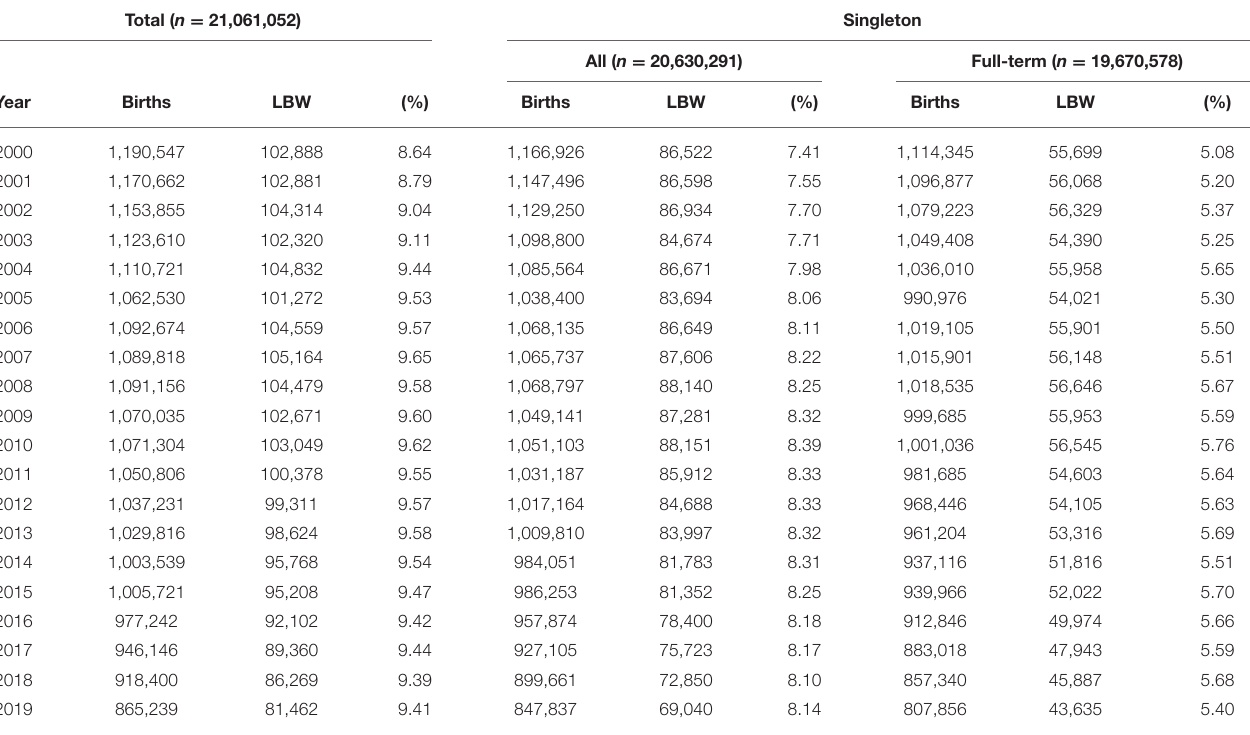
TABLE 1 | Birth rate data for all births and low birth weight (LBW) in singleton births in Japan from 2000 to 2019. Total ( n = 21,061,052)